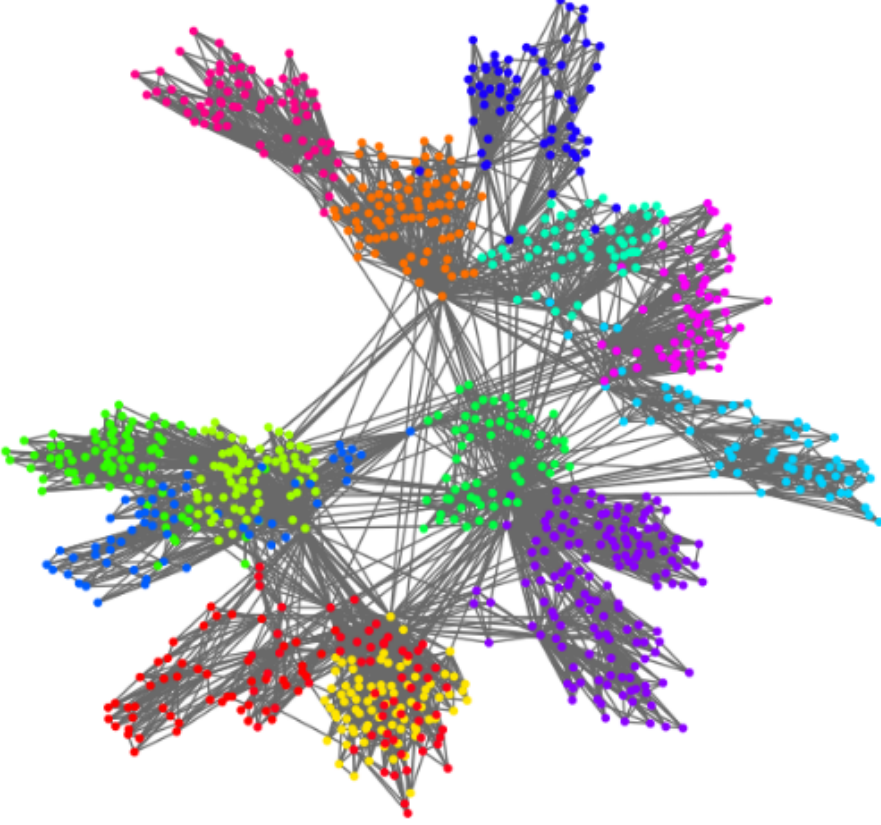
Figure 5. The community discovery visualization of nPSO-1 based on the Louvian